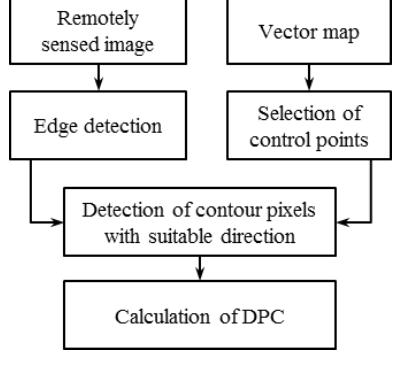
Figure 3. Calculation of